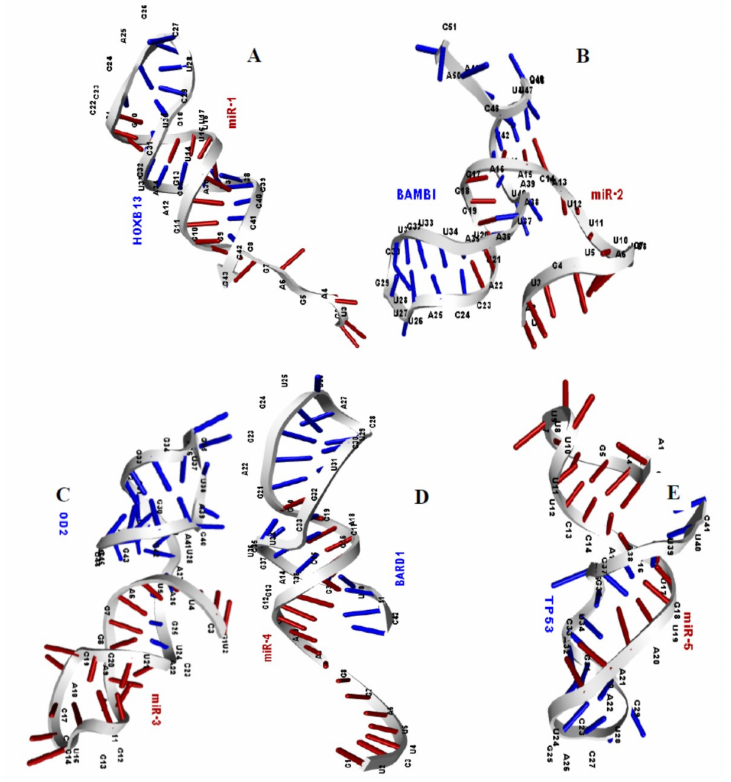
Figure 4. Structural model of miR-1 and mRNA of HOXB13 gene ( A ), miR-2 and mRNA of BAMBI gene ( B ), miR-3 and mRNA of SOD2 gene ( C ), miR-4 and mRNA of BARD1 gene ( D ), miR-5 and mRNA of TP53 gene ( E ), complexes are deciphered,